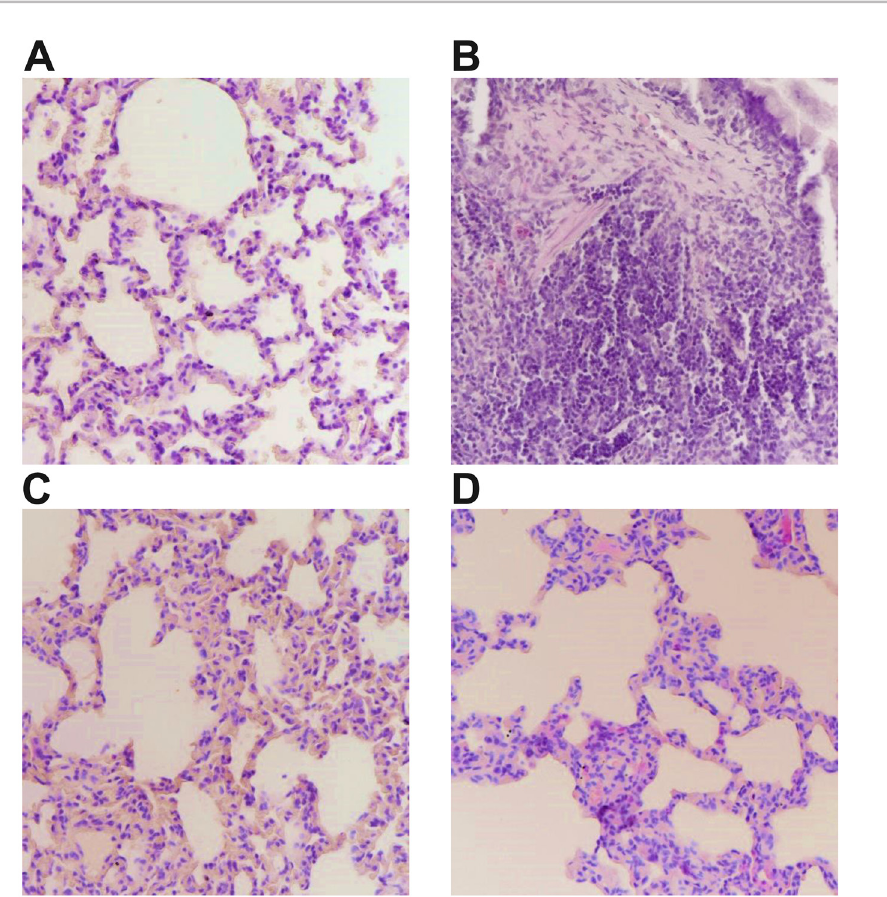
FIGURE 3 - Histopathological observation for lungs in different groups (HE, 200×. A: Montmorillonitec control group; B: PQ poisoning group; C: Immediate treatment group; D: Delayed treatment group).